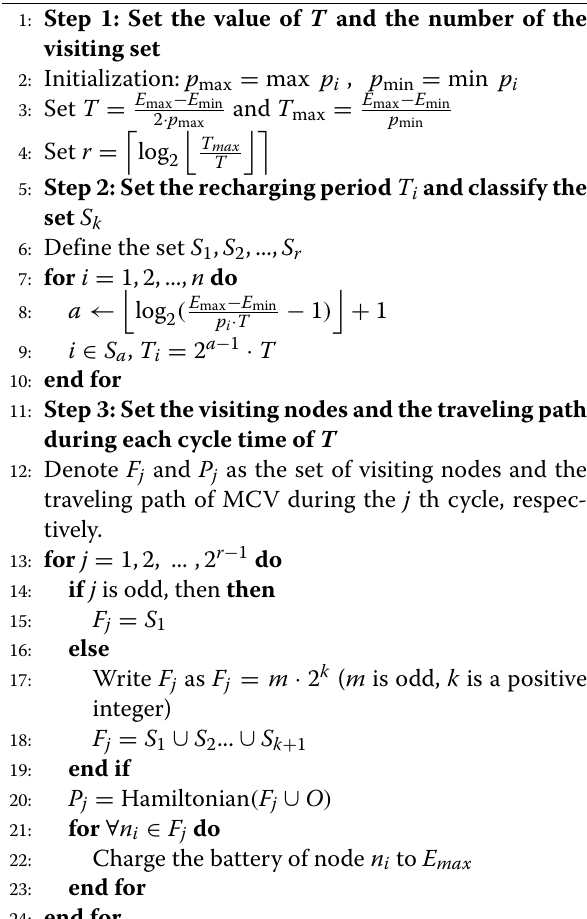
Algorithm 1 The procedure of joint design for